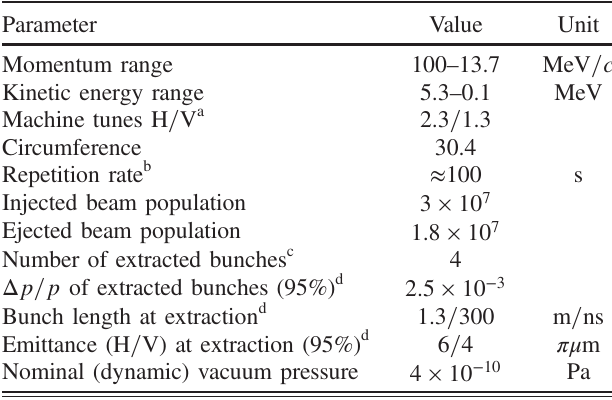
TABLE II. Parameters of ELENA ring bending